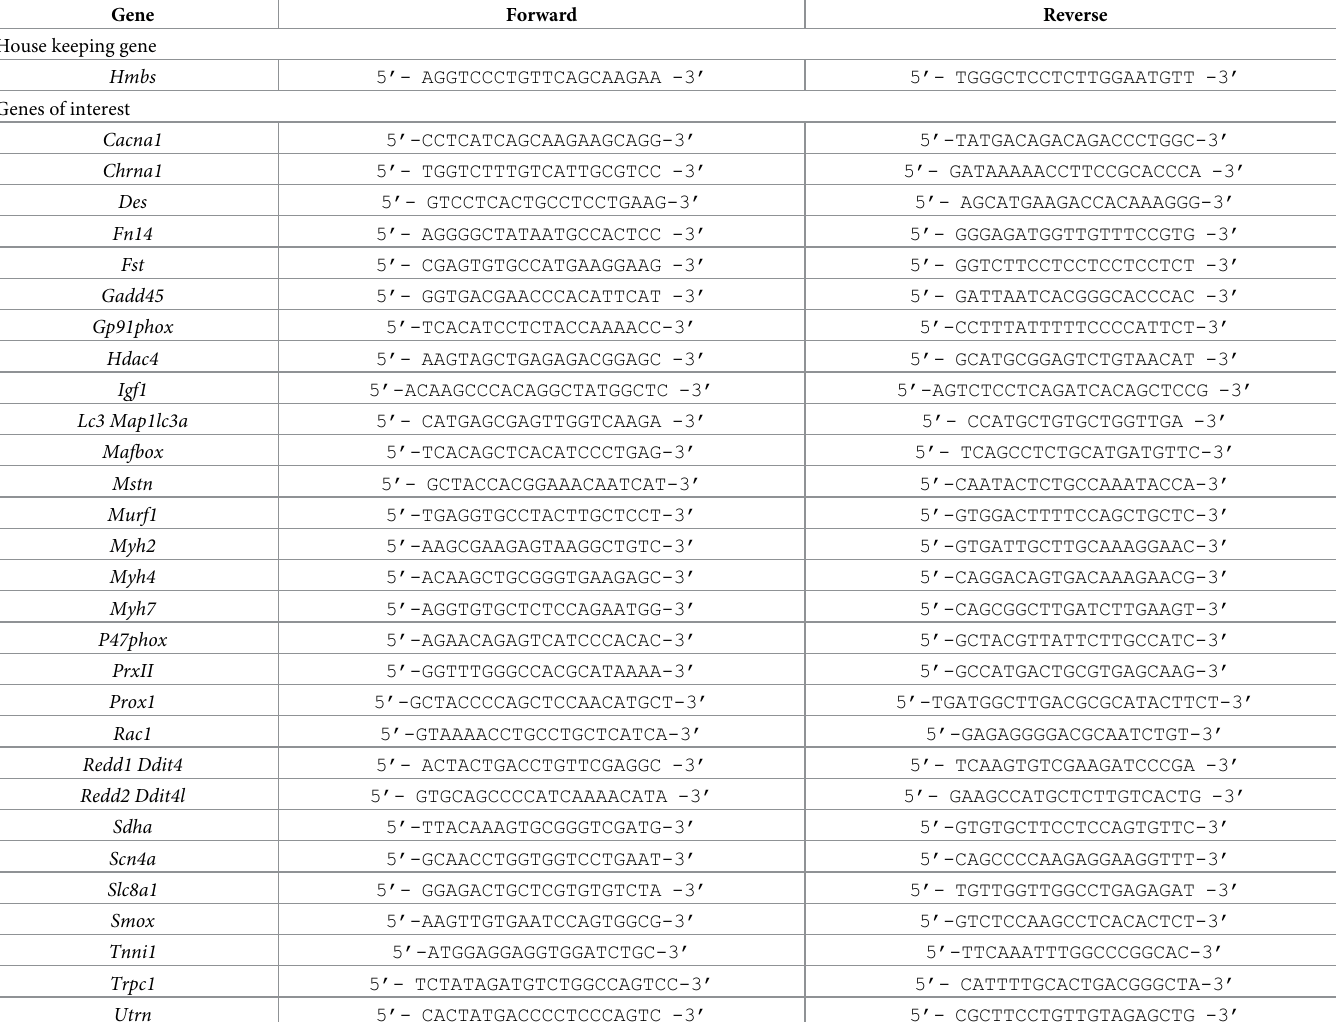
Table 1. Sequences of primers